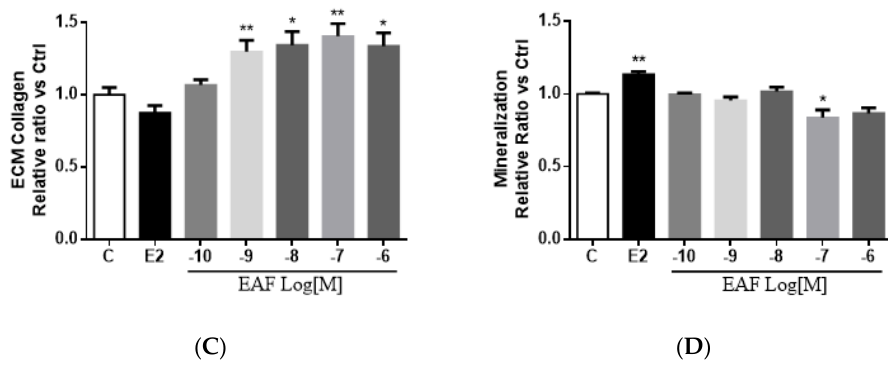
Figure 3. ( − )- epi afzelechin (EAF) stimulatedosteoblastic functions in MC3T3-E1 cells. ( A ) Cell proliferation was determined by MTS assay upon treatment of MC3T3-E1 cells with 10 − 8 M of E2, 10 − 10 to 10 − 6 M of EAF, or its vehicle (1% EtOH v/v ) for 1day; ( B ) Alkaline phosphatase activities and ( C ) collagen content were determined upon treatment of cells with 10 − 8 M of E2, 10 − 10 to 10 − 6 M of EAF, or its vehicle (1% EtOH v/v ) for seven days; ( D ) Mineralization was determined by Alizard Red S staining upon treatment of cells with 10 − 8 M of E2, 10 − 10 to 10 − 6 M of EAF, or its vehicle (1% EtOH v/v ) for 21 days. The stained plates were dissolved in 5% SDS and 0.5 M HCl for colorimetric determination. The relative cell proliferation rate, alkaline phosphatase (ALP) activity, collagen content, and degree of mineralization were presentedas mean ± SEM value with n = 3. * p < 0.05, ** p < 0.01, and *** p < 0.001 vs. vehicle.